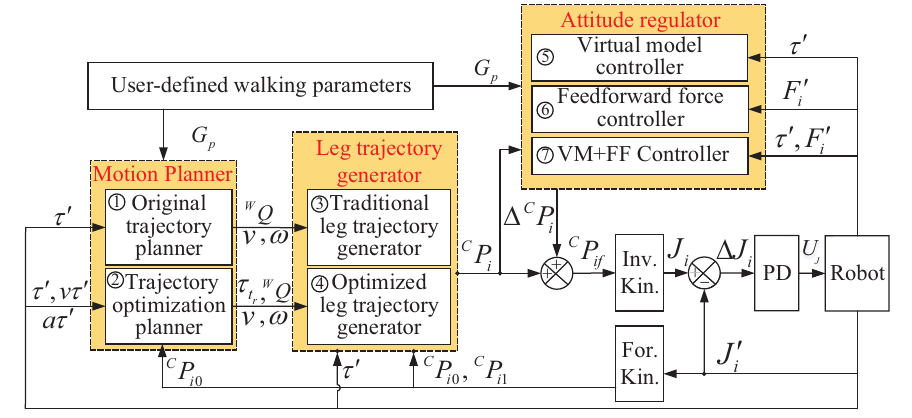
Figure 9. The brief structure of the control scheme of the robot. Table 1. Unknown parameters of the control